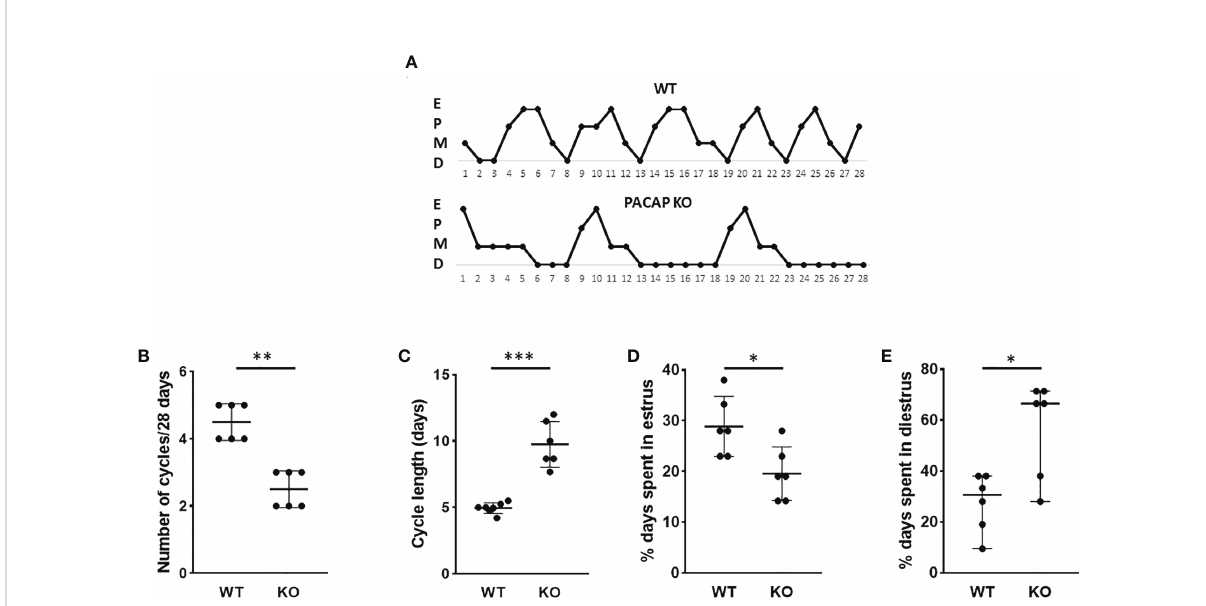
FIGURE 1 Disrupted estrous cyclicity in PACAP KO mice. Representative estrous cycle diagrams illustrate the alterations in estrous cycle in WT and PACAP KO mice (A) . Dot plots depict the number of estrous cycles in 4 weeks (B) , the cycle length (C) , and the percentage of time spent in estrus (D) and diestrus (E) . Graphs show the mean ± SD for panels (C, D) and the median ± range for panels (B, E) n = 6 – 6, * p < 0.05, ** p < 0.01, *** p <